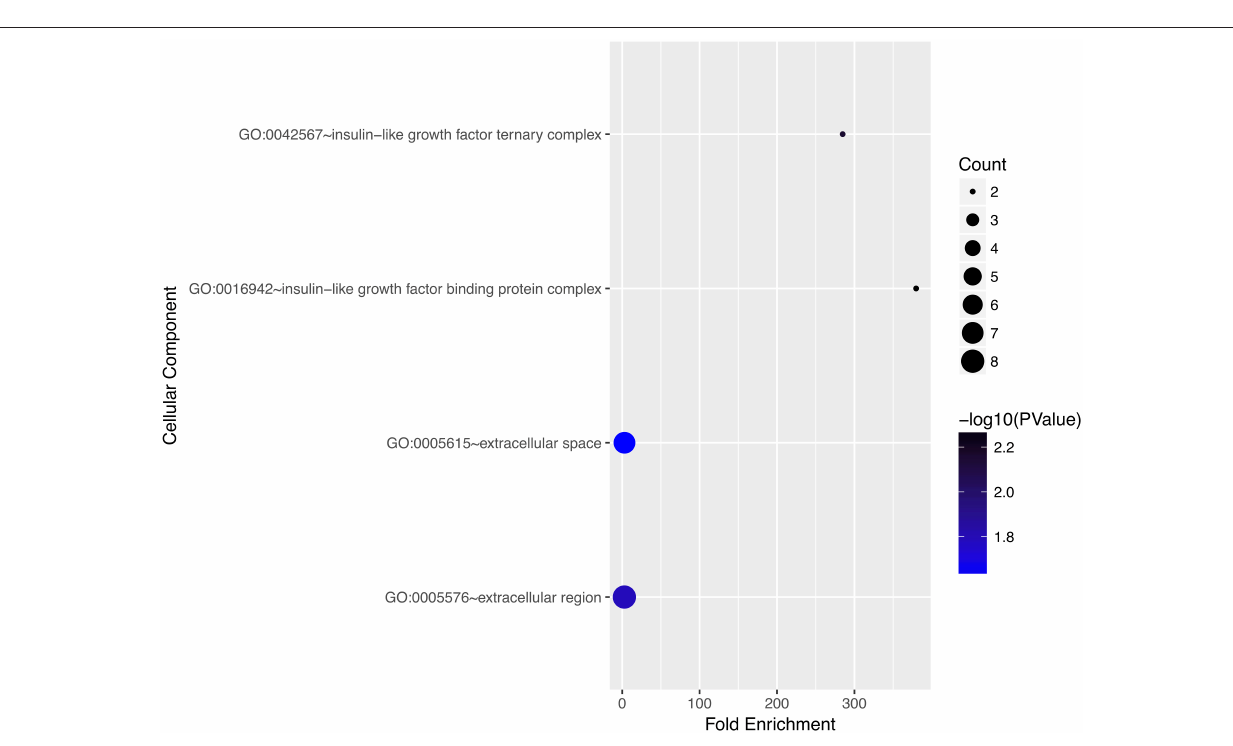
Frontiers in Endocrinology |